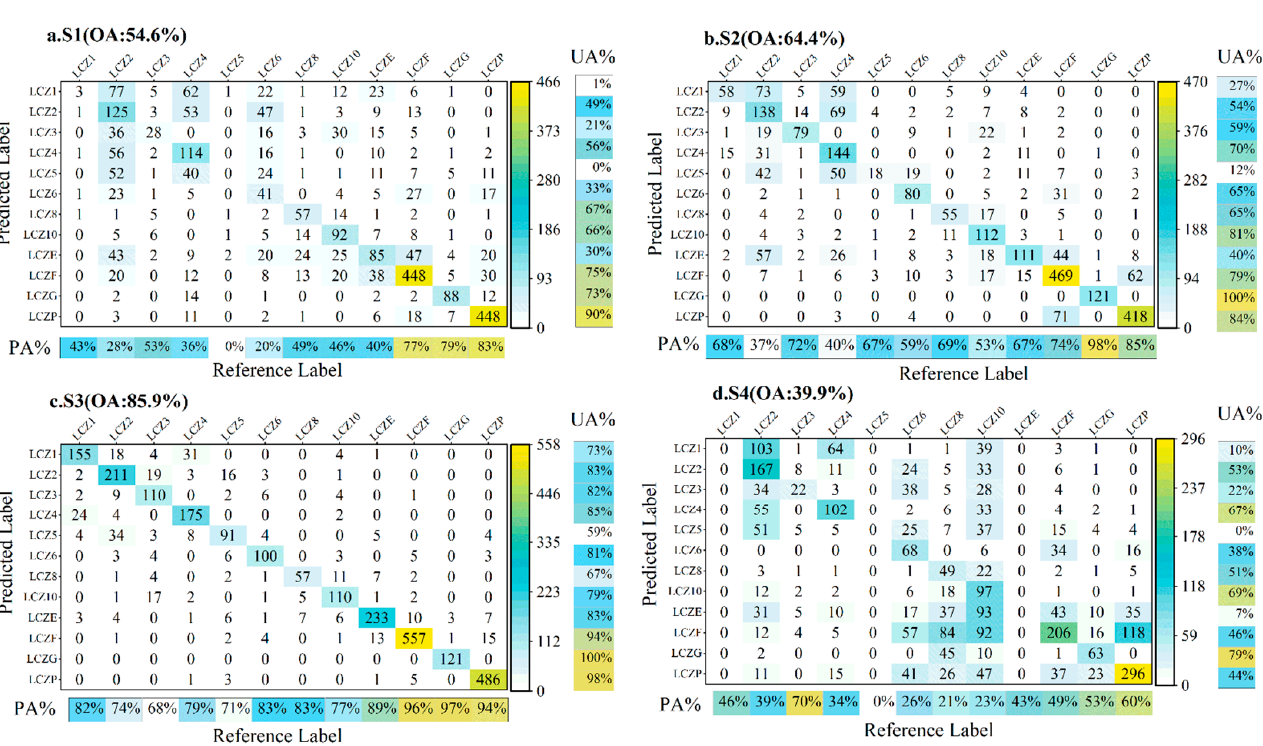
Figure 5. Confusion matrix of the S1 scheme ( a ); confusion matrix of the S2 scheme ( b ); confusion matrix of the S3 scheme ( c ); confusion matrix of the S4 scheme ( d ).